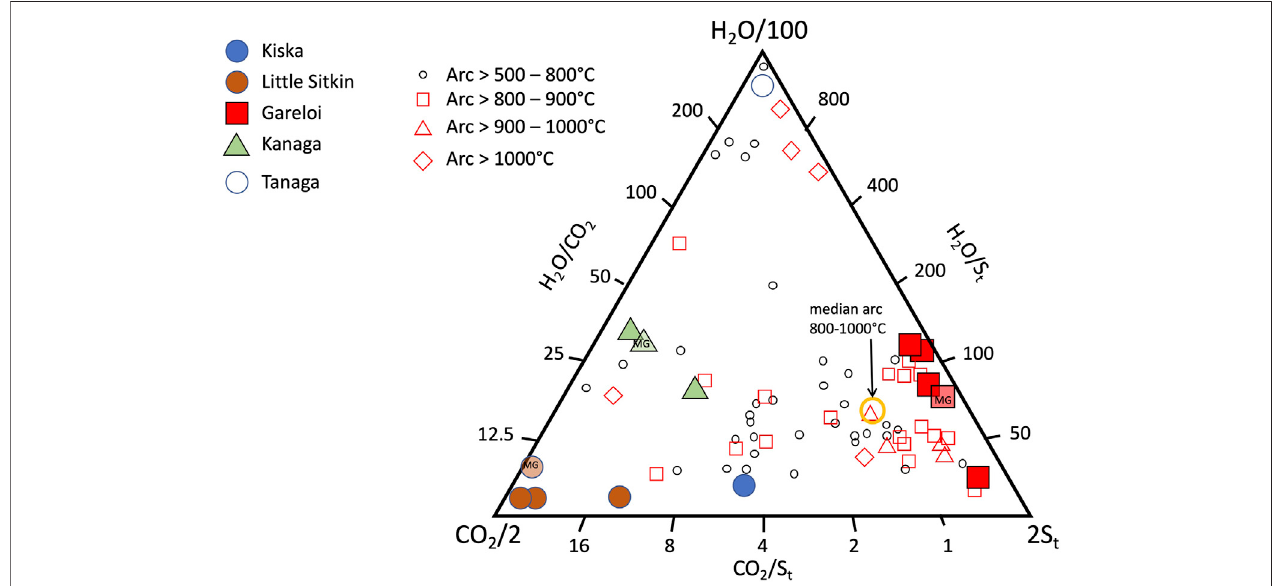
FIGURE6| H 2 O,CO 2 andS t (SO 2 +H 2 S)relative abundancesofgassamplescollectedinthisstudy.Alsoshown arehightemperature gasdatafromarcfumaroles (Taran and Zelenski, 2015) for comparison.